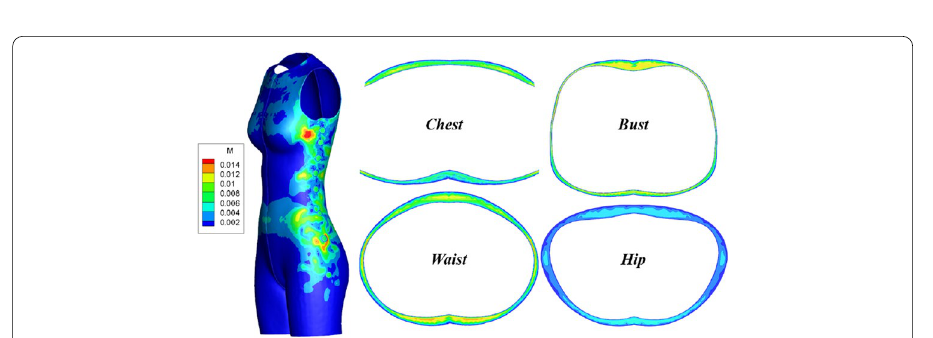
Fig. 9 Air flow contours of air gap and body